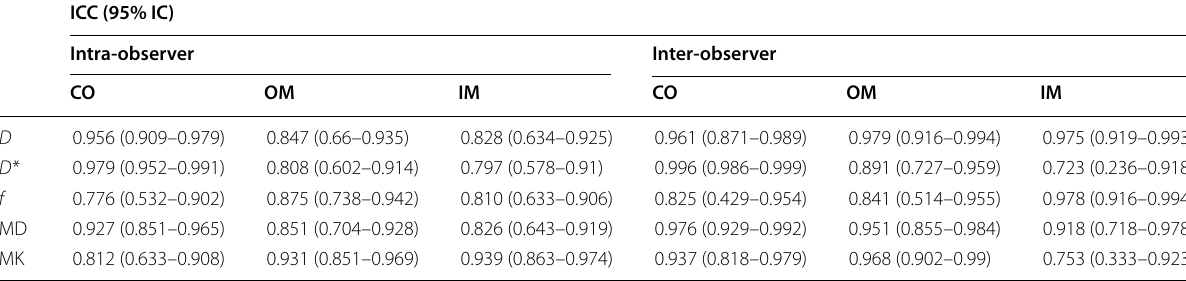
All the ICCs reached significant ( p <